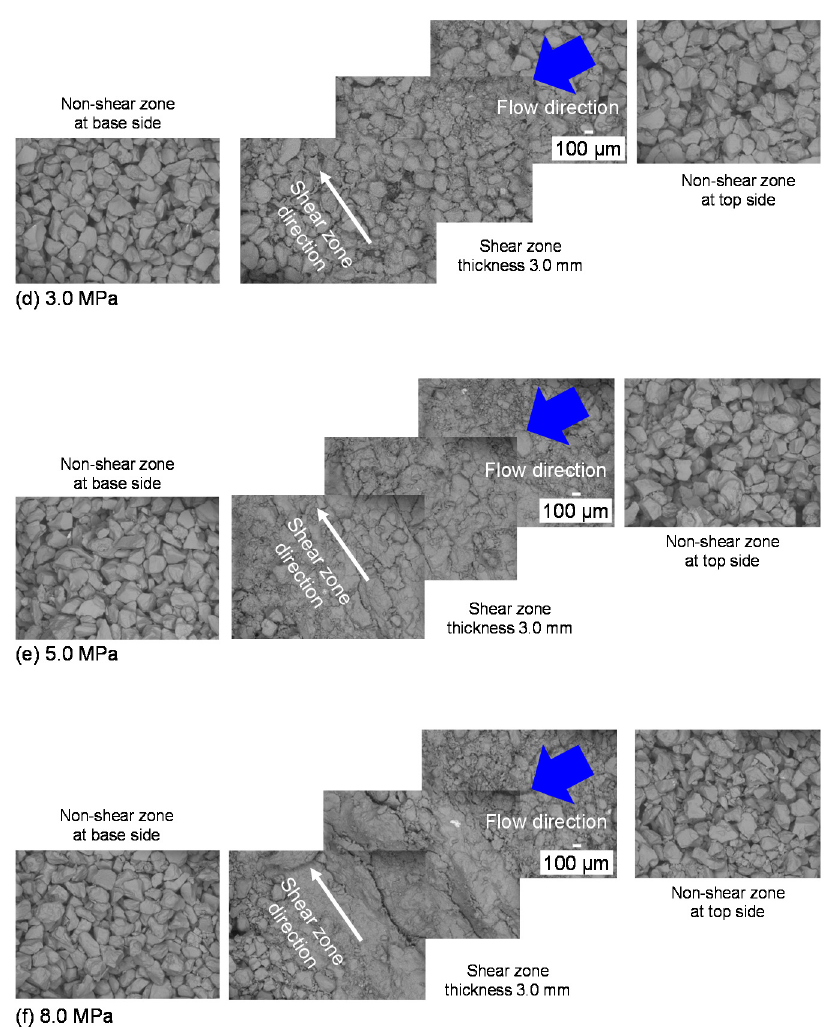
Figure 6. FE-SEM images of shear zones and non-shear zones for Toyoura sand at each effective normal stress. Continued for Toyoura sand at ( a ) 0.5 MPa; ( b ) 1.0 MPa; ( c ) 2.0 MPa; ( d ) 3.0 MPa; ( e ) 5.0 MPa; and ( f ) 8.0